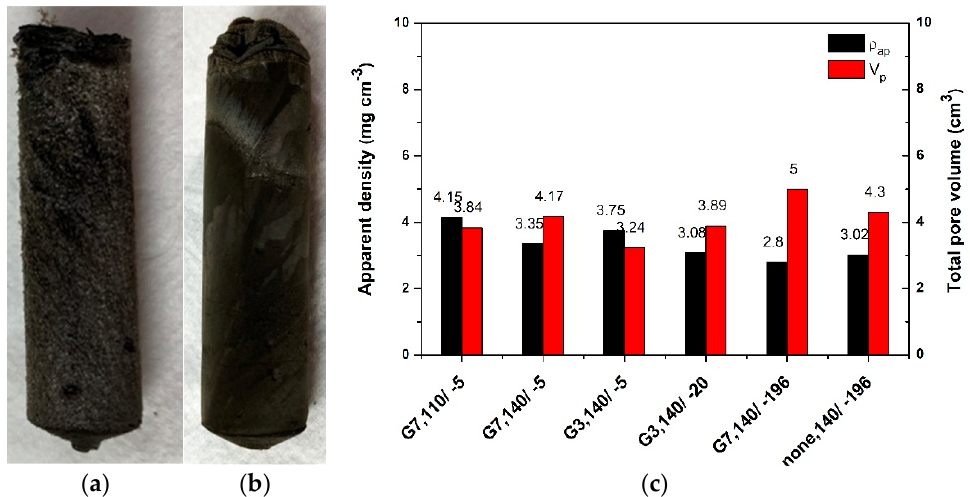
Figure 2. ( a ) Images of G7 PAMAM-modified rGO aerogels freeze-cast at T FC of − 5 °C and ( b ) − 196 °C; ( c ) Evolution of apparent density and total pore volume (dendrimer concentration when present: 0.2 mg mL − 1 , T HT /T FC °C).